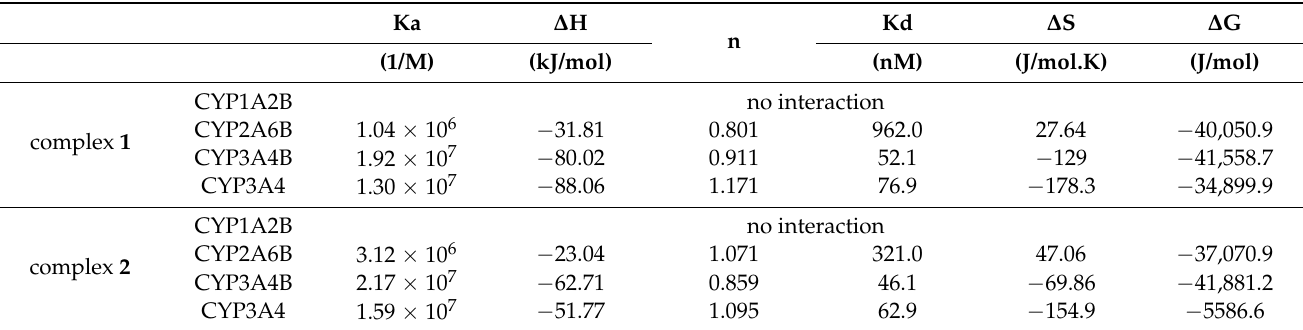
Table 4. Thermodynamic parameters defining the interactions of complexes 1 and 2 with CYPs based on ITC